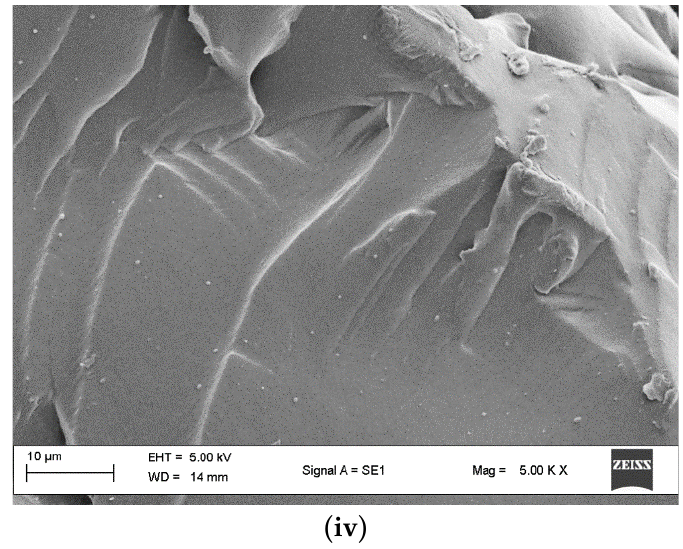
Figure 4. SEM images of crude amino-Li-resins: ( i ) 200 µm; ( ii ) 100 µm; ( iii ) 20 µm; and ( iv ) 10